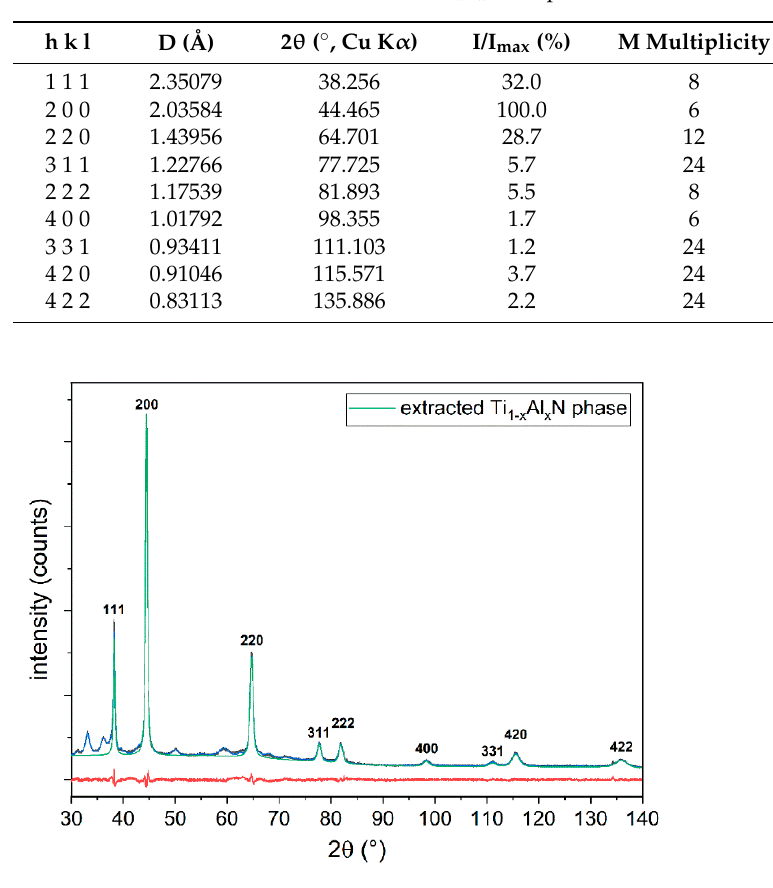
Figure 8. XRD diffractogram of the Ti 1 − x Al x N powder sample (blue diffractogram) and extracted XRD diffractogram of the fcc-Ti 1 − x Al x N phase (green diffractogram). Below the red difference curve of the fitting procedure is given.